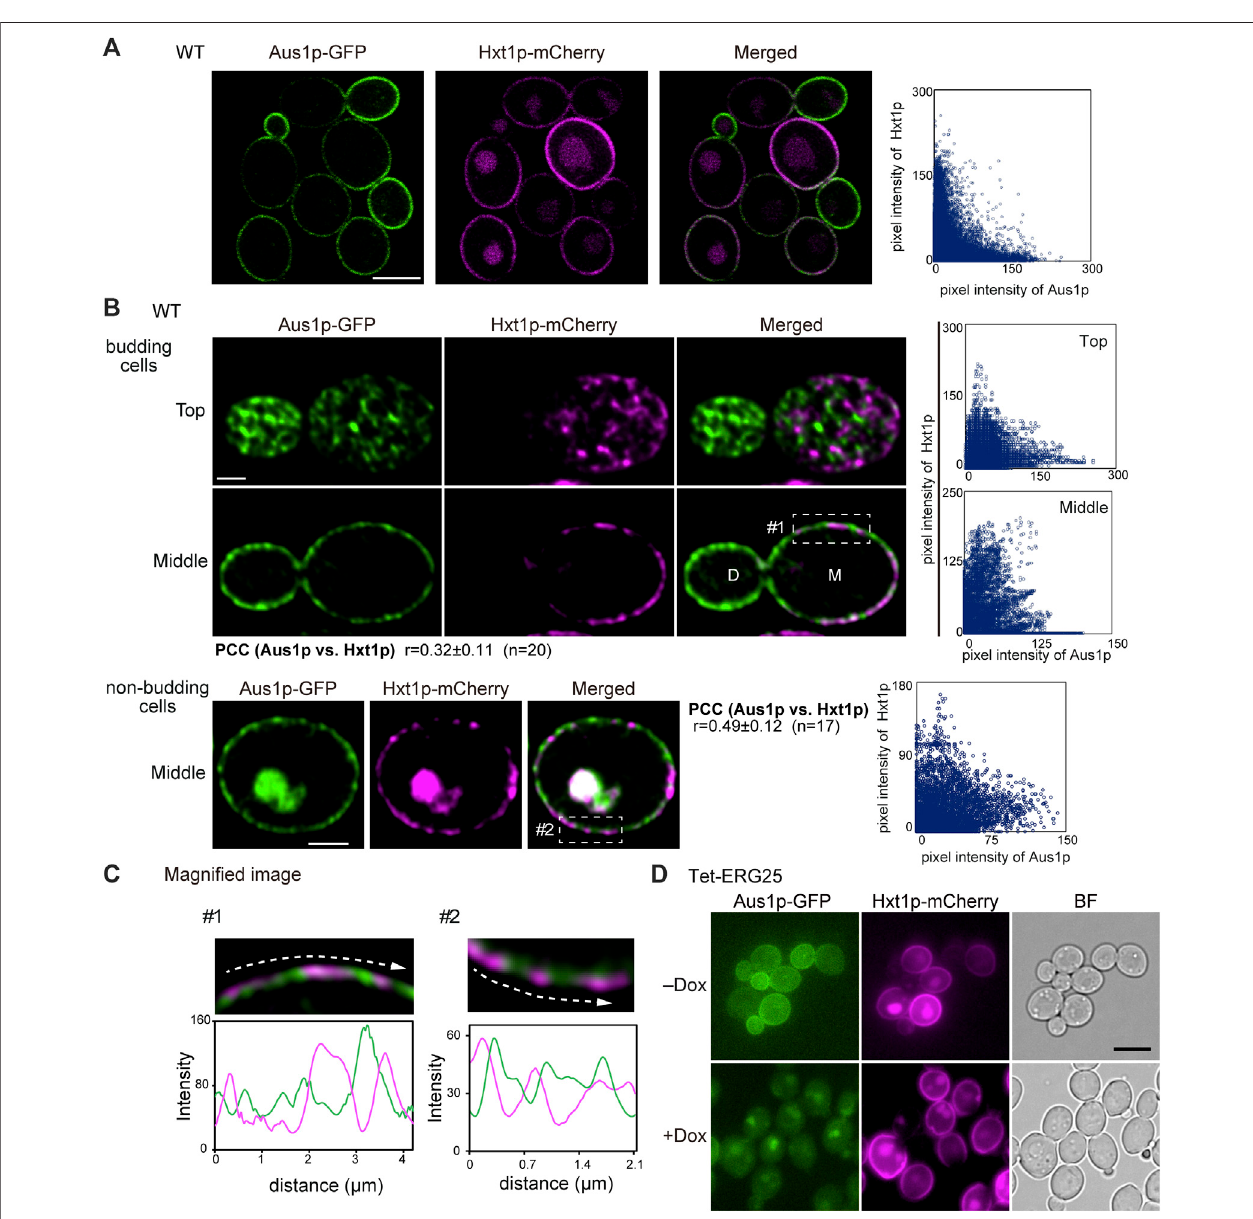
FIGURE 5 | The plasma membrane distributions of Aus1p and Hxt1p are different, and ERG25 knockdown has no effect on the localization of Hxt1p. (A) Distribution of Aus1p and Hxt1p on the plasma membrane. Wild-type cells co-expressing Aus1p-GFP and Hxt1p-mCherry (WT_Aus1G/Hxt1R) cells were grown to exponential phase at 30 ° C in minimal medium containing bovine serum. Scatterplot of green and magenta pixel intensities of Aus1p-GFP and Hxt1p-mCherry was shown in the right panel. Scale bar represents 2.5 µm. (B) WT_Aus1G/Hxt1R cells were observed at high resolution by focusing on the top and middle of the cells using aconfocal fl uorescence microscope.Scatterplots ineach cellwererepresentedinthe rightpanel. PCC between the fl uorescentsignalsobtainedwithAus1p-GFP and Hxt1p-mCherry in budding or non-budding cells were indicated. Scale bars represent 1 µm. D, daughter cell; M, mother cell. (C) Magni fi ed image of the area enclosed by the dashed lines in (B) . Intensity pro fi ling of GFP (green) and mCherry (magenta) on the plasma membrane was carried out along the dashed arrows. (D) Effect of ERG25 knockdown on the localization of Hxt1p. Tet-ERG25 cells that expresses Aus1p-GFP and Hxt1p-mCherry (Tet-ERG25_Aus1G/Hxt1R) were grown to exponentialphaseat30 ° Cinminimalmedium containing10%(v/v)bovineserum andobservedusing fl uorescencemicroscopyafterincubationwithorwithout20 μ g/ml Dox for 3.5 h. Scale bar represents 2.5 µm.